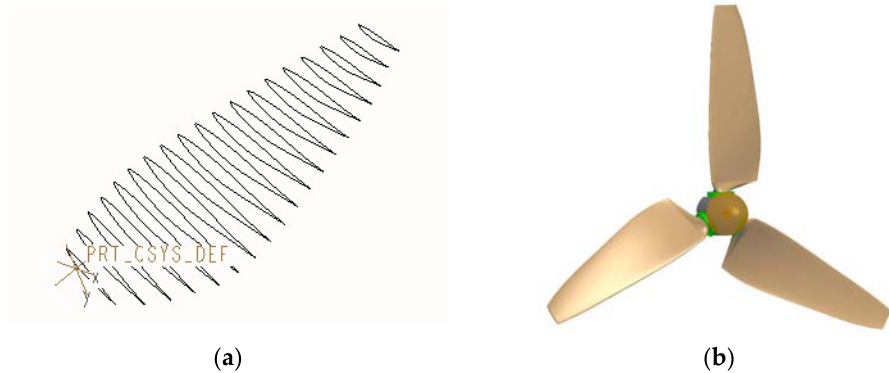
Figure 11. ( a ) Blade element diagram of Blade I. ( b ) Three-dimentional modeling diagram of Blade I.